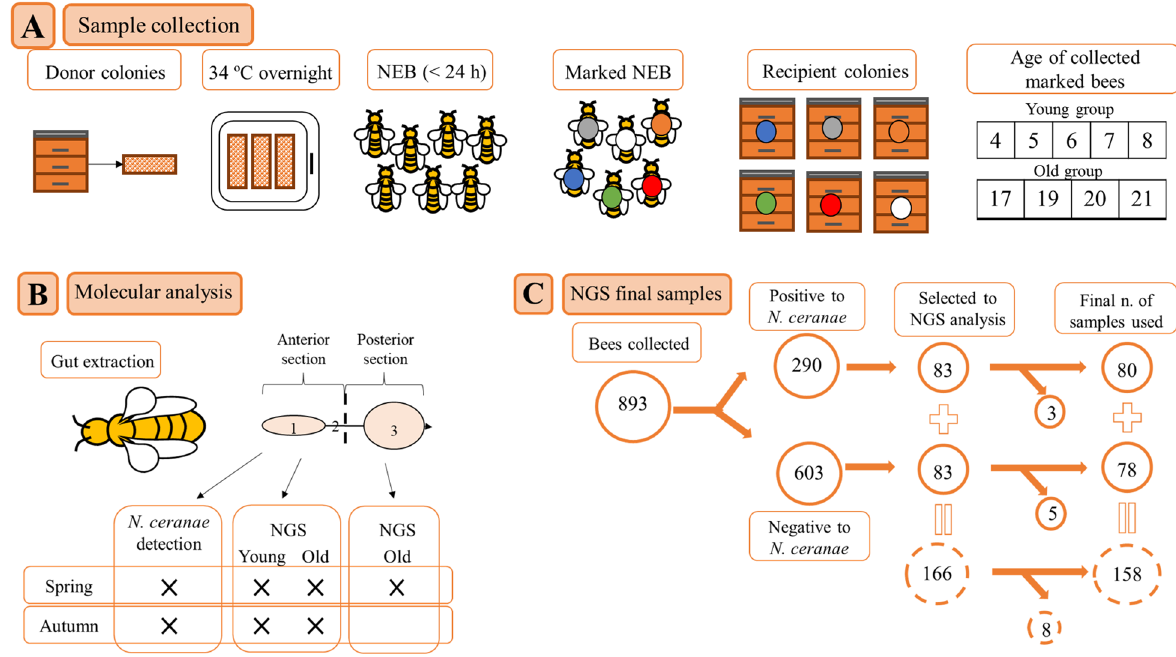
Figure 1. Experimental design. ( A ) Sample collection. In both seasons, capped brood frames were taken from donor colonies and put in an incubator overnight to obtain newly emerged bees (NEB). The bees were marked and distributed in groups in recipient colonies. The collected bees were grouped in young and adult bees and analyzed in the laboratory. ( B ) Molecular analysis. The gut (from midgut to rectum) was extracted and cut in two: anterior section (ventriculum (1) and half of the ileum (2)) and posterior section (half of the ileum (2) and rectum (3)), indicated by the dashed line. Samples were assessed for N. ceranae and metataxonomic analyses as indicated. ( C ) Next generation sequencing (NGS) final samples. Selection of samples from the total number of bees collected towards the final samples used for the metataxonomic analyses. In the process of DNA extraction and sequencing, 8 samples were discarded (3 positive and 5 negative to